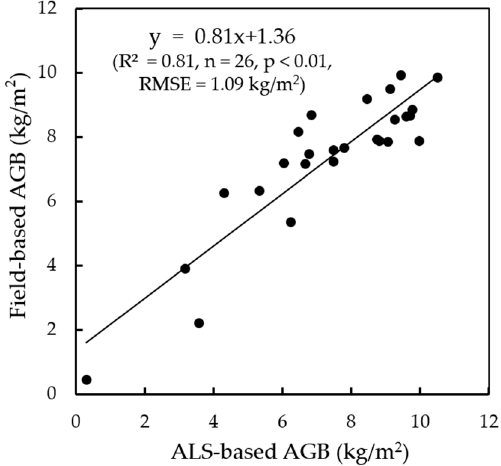
Figure 4. The validation of ALS-based forest AGB in 2012 using the results obtained from forest field-based AGB at the plot level.